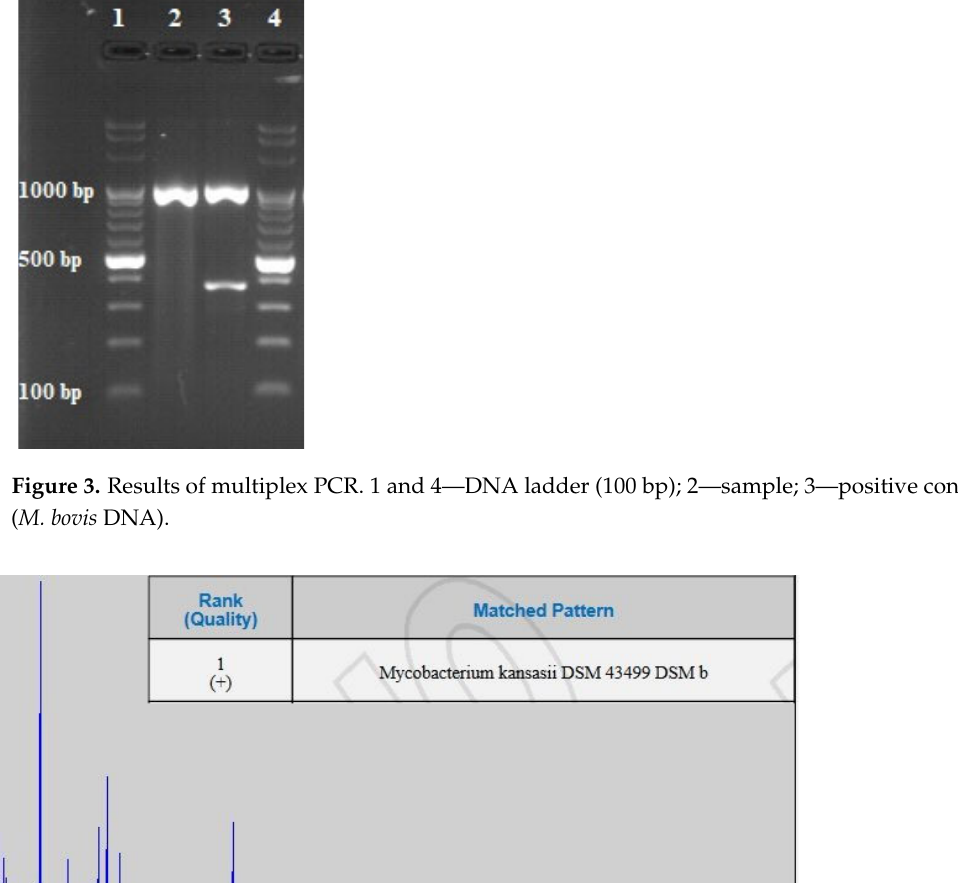
Figure 2. Acid ‐ fast rods (Ziehl ‐ Neelsen staining, ×1000) .